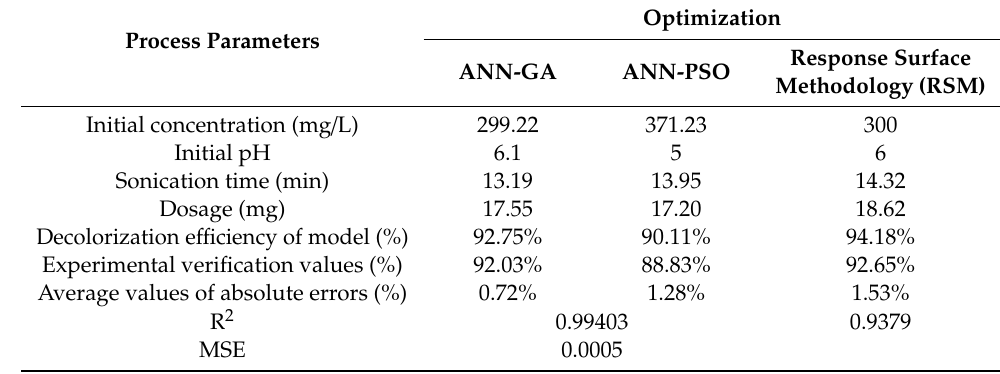
Figure 20. Genetic algorithm (GA) and particle swarm optimization (PSO) chart predicted optimum value of EV removal efficiency. Table 4. Comparison of the confirmatory results with predicted results.